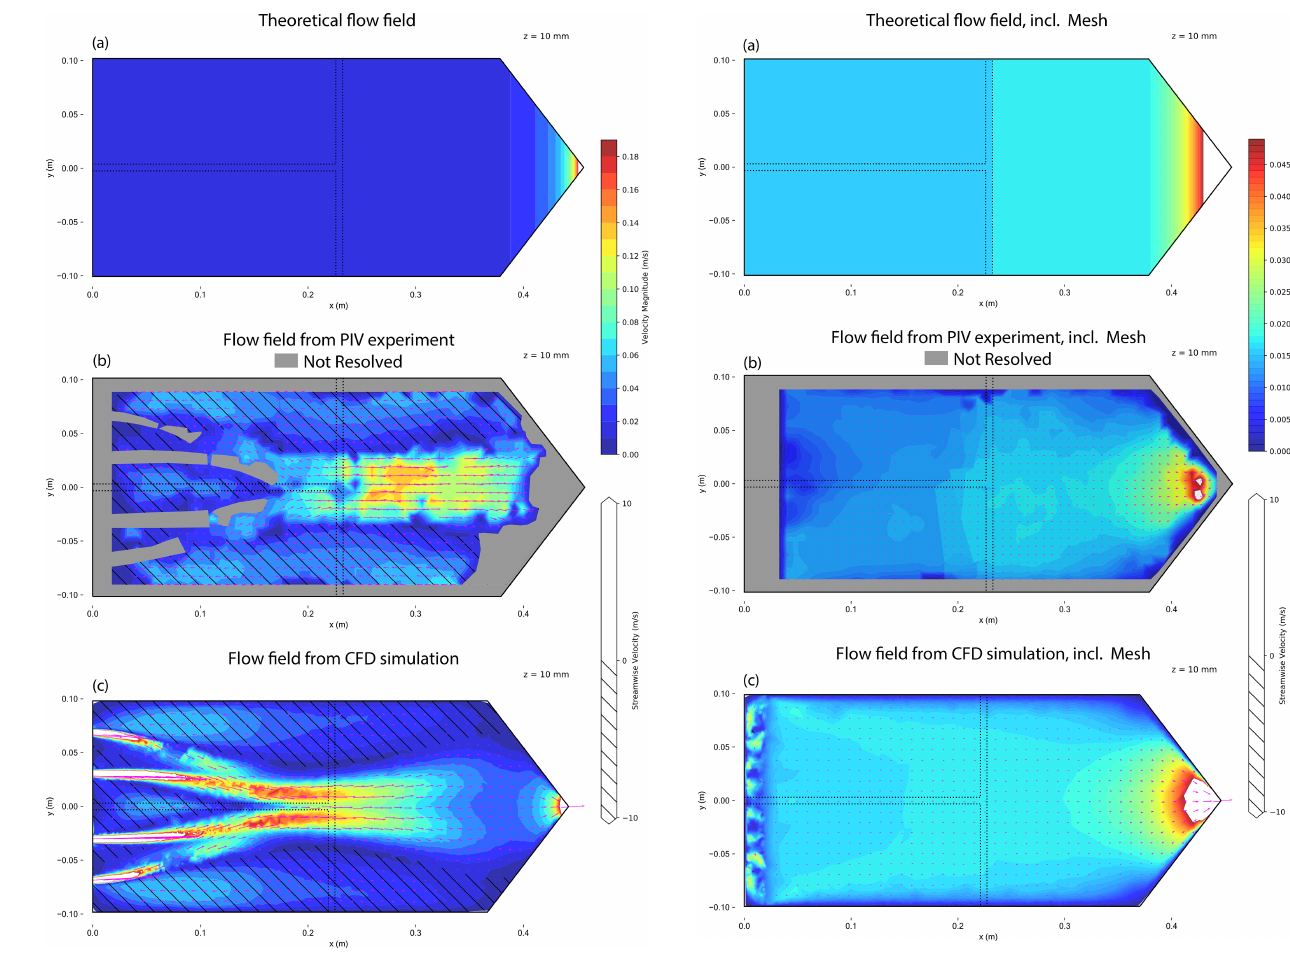
Figure A3. Contour plot of flow velocity magnitudes at a horizontal plane of the HINC cavity at mid-height including a mesh installed at x inj = 0 . 022m. The chamber is set to T = 243K and S w = 1 . 04. Theoretical flow field (a) , flow field measured using PIV (b) and simulated flow field from CFD (c) . Arrows indicate flow direction; the hatching marks regions with reversed flow. The dashed line rep- resents a possible position of the